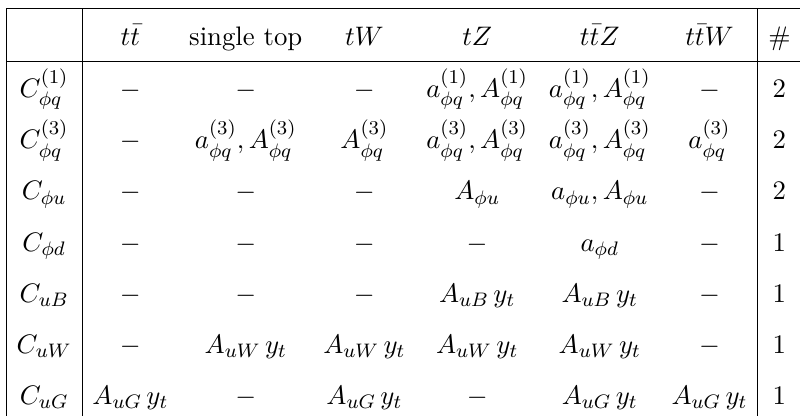
) or smaller and b